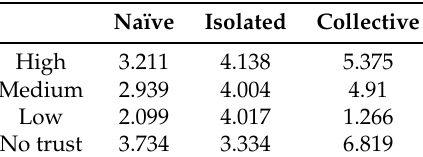
Table 7. Service time with 10% malicious.